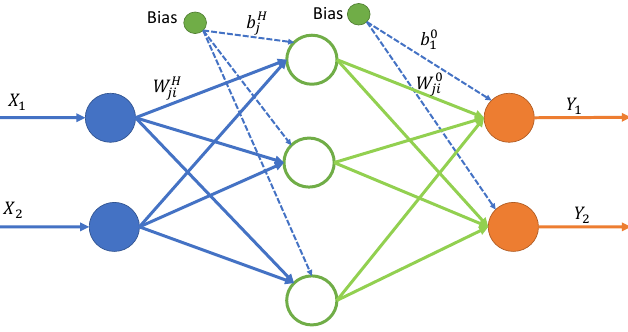
Figure 4. Representation of a multilayer perceptron, with input X, one hidden layer, and output